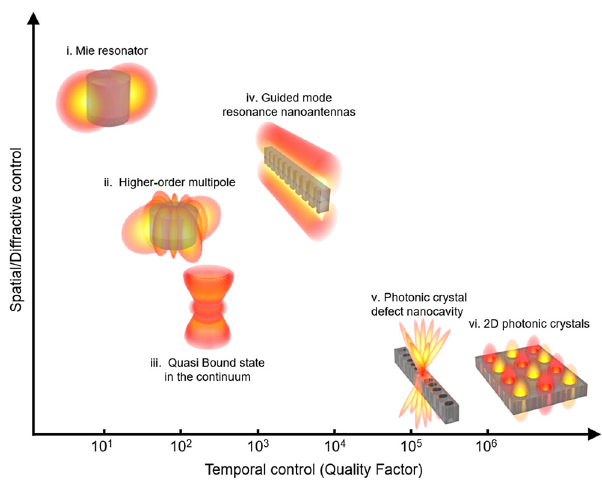
Figure 1: Landscape of dielectric nanophotonic structures for temporalandspatialcontroloflight.Fromleftto right:Conventional Mie resonator used for wavefront shaping in metasurfaces. Higher order multipoles increase the quality factor, at the expense of more complex radiation patterns. Interfering Mie-like and Fabry-Perot – like resonances increases the quality factor compared to dipole resonances, forming a quasi-bound state in the continuum ( Q value from the study by Koshelev et al. [31]). Utilizing one translational degree of freedom, coupling to guided mode resonances within a nanoantenna can generate high- Q dipolar-like resonances for wavefront shaping, with a quality factor tuned independently of the metasurface transfer function ( Q value taken from the study by Lawrence et al. [30]). Photonic crystal defect nanocavities increase the Q to 10 6 using photonic mirrors but lose the ability to con- trollably shape far- fi eld radiation ( Q from the study by Quan and Loncar [49]). Photonic crystals with two spatial degrees of freedom generate ultrahigh-quality factors whose resonant diffraction is geometrically set ( Q from the study by Jin et al.